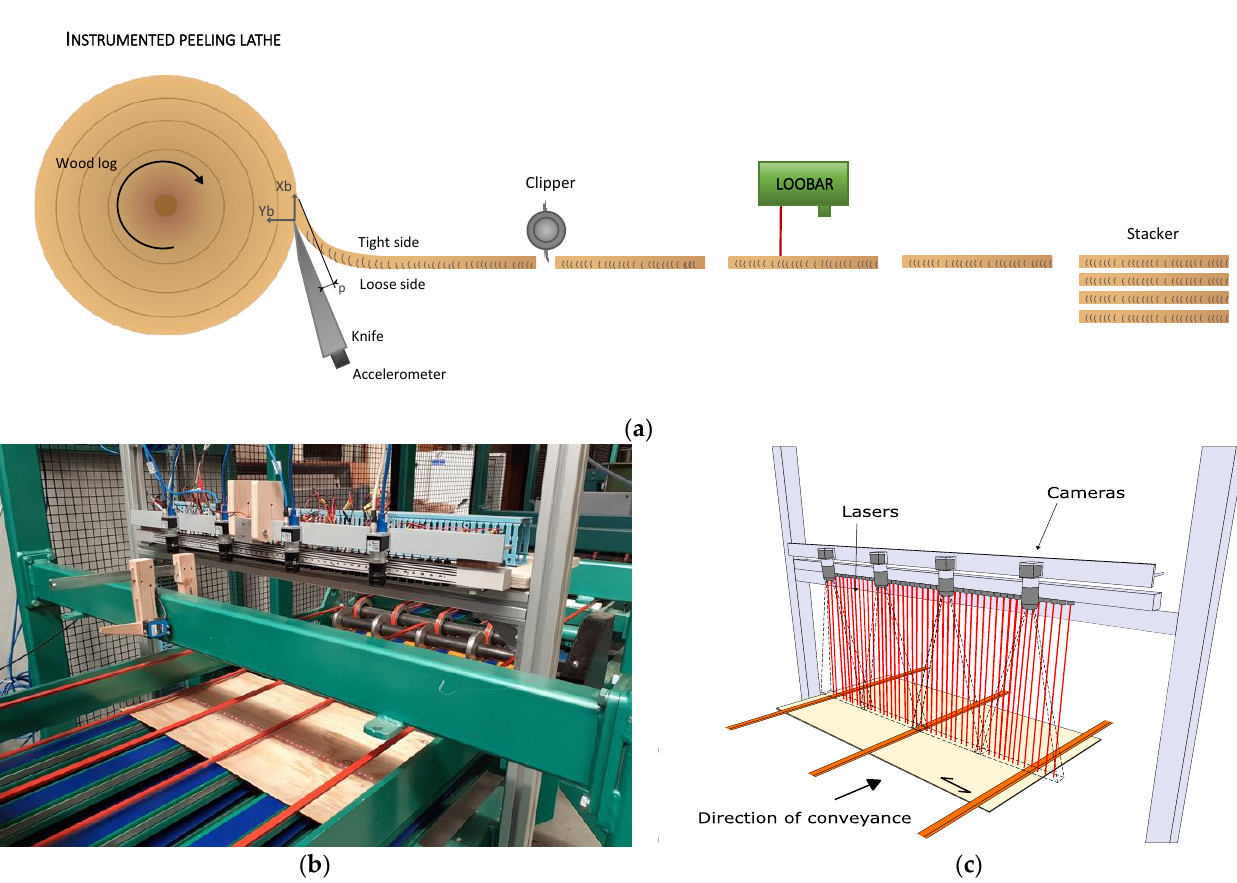
Figure 1. The LOOBAR, a veneer fiber orientation-measuring device integrated to the LaBoMaP peeling line: ( a ) schematic representation of LaBoMaP’s instrumented rotary peeling line, ( b ) picture, ( c ) scheme.